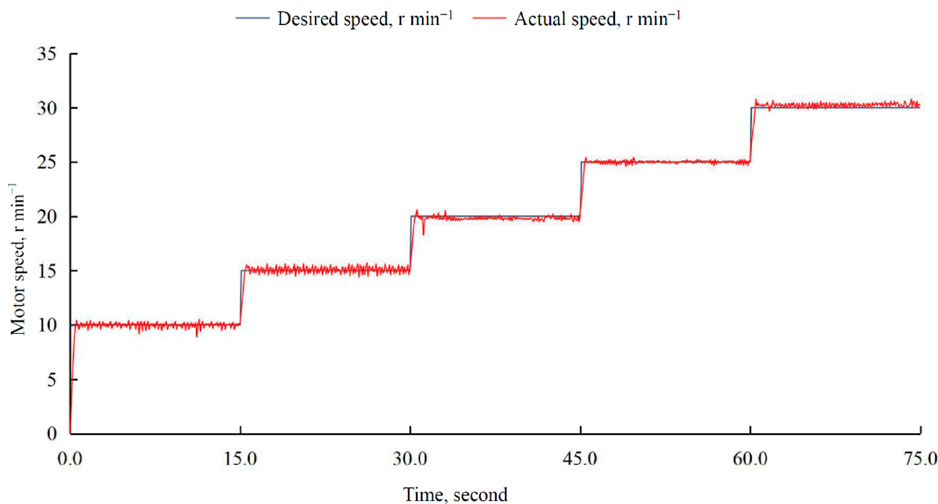
Figure 5. Desired speed versus actual motor speed.